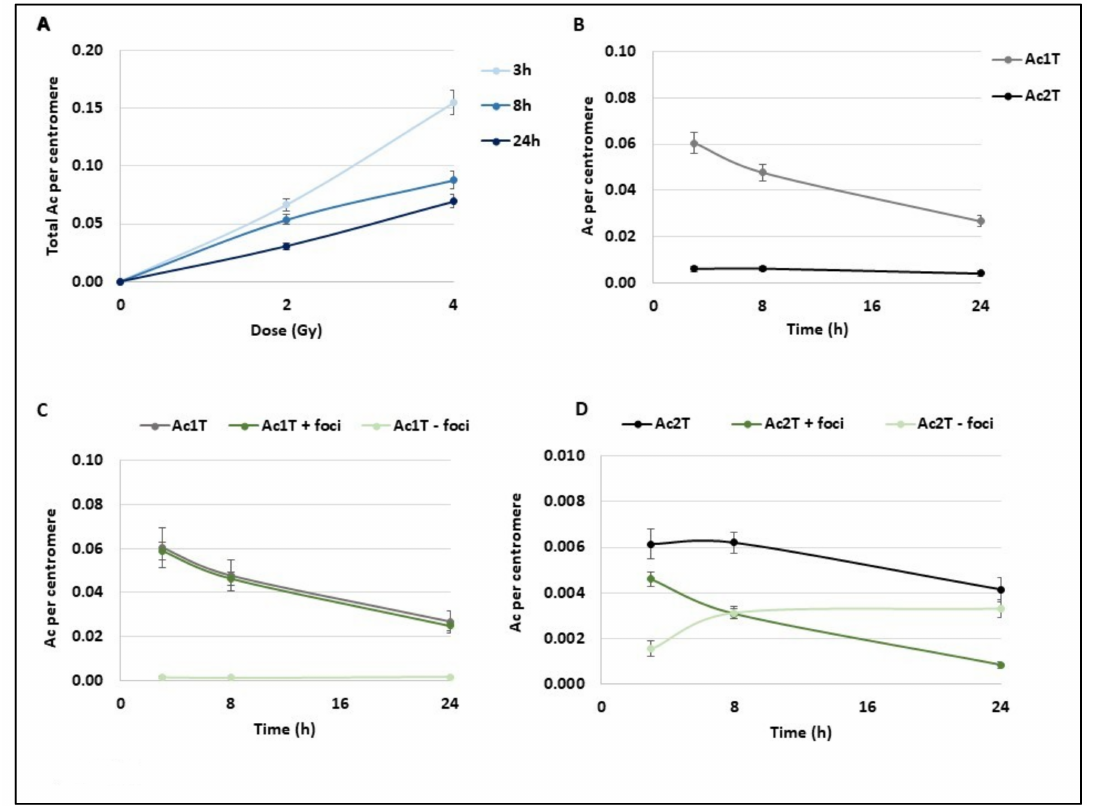
Figure 3. Kinetics of di ff erent subtypes of acentric fragments after radiation exposure. Blood samples from three donors were irradiated at 2 or 4 Gy or kept free from ionising radiation and analysed using the PCC technique. ( A ) After Telomere / Centromere staining on PCC, the total number of acentric fragments per centromere was scored for each dose and 3 h, 8 h, and 24 h post-IR. The total acentric fragments increase with dose and decrease overtime. Bars represent standard deviation. ( B – D ) Focus was made on PCC analysis after 2 Gy radiation exposure. Bars represent standard